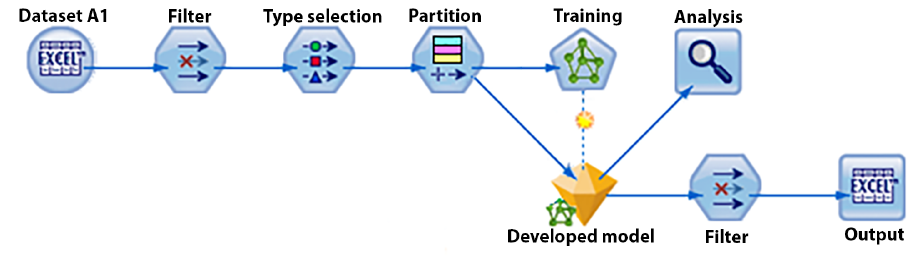
Figure 7. Validation data stream developed in IBM